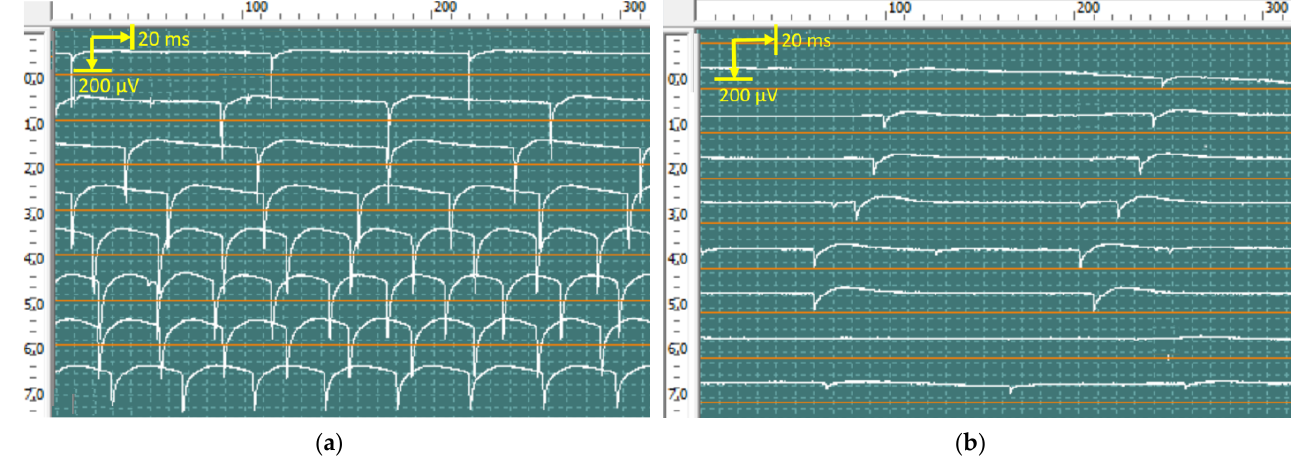
Figure 10. Recorded positive sharp waves from the first dorsal interosseous muscle of the left ( a ) and right ( b ) hands via concentric needles. The amplitude of positive sharp waves was 850 μV in the right hand and 350 μV in the left hand.